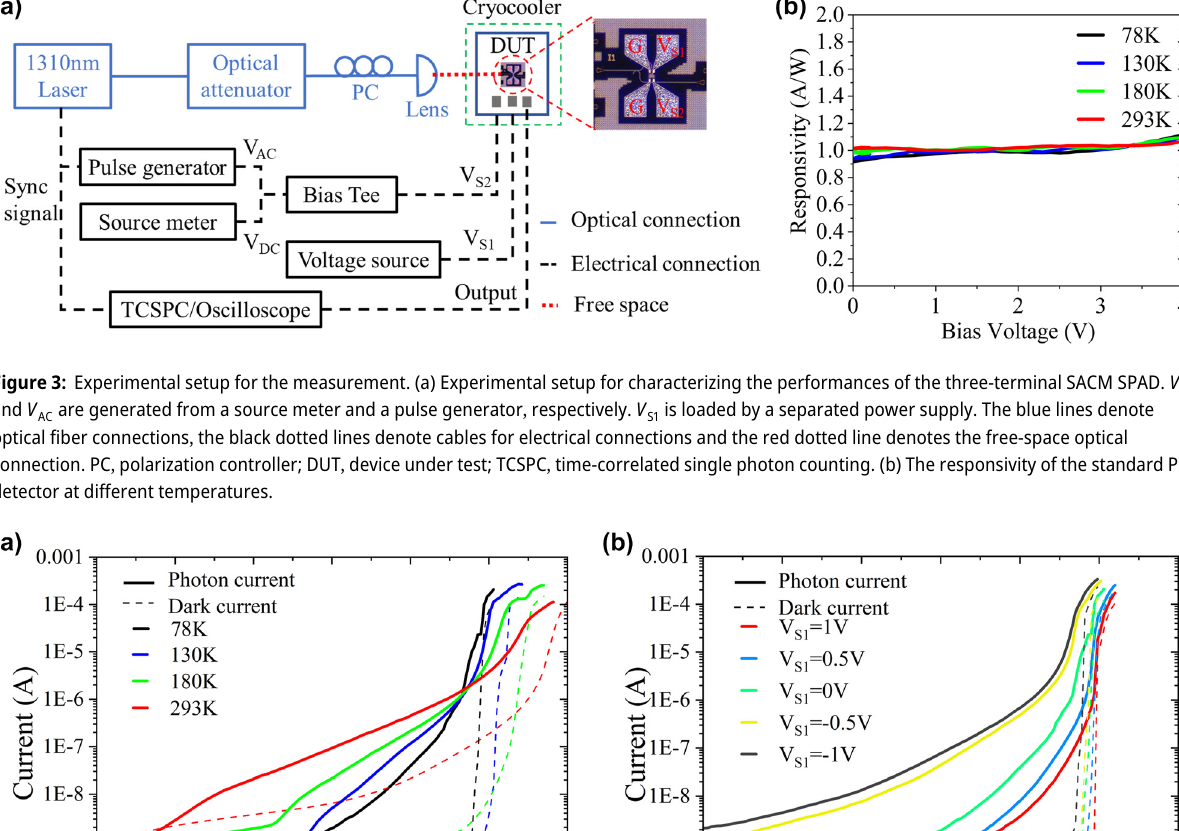
Figure 4: The measured I – V curves of the device. (a) The measured I – V curves of the device at temperature from 293 K to 78 K when the voltage V 0 V. The solid and dashed lines represent the photocurrent and dark current, respectively. (b) The I – V curves of the detector with different V